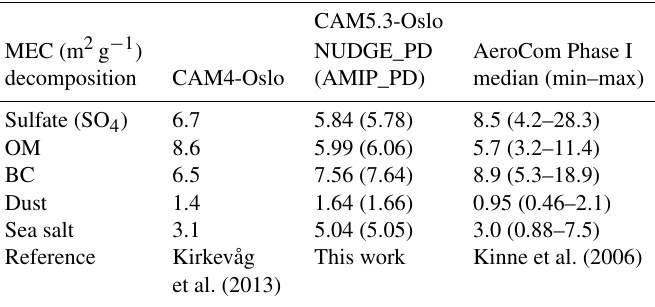
Table 9. Globally and annually averaged PD mass extinction coefficients at 550nm for each of the main aerosol components in CAM5.3- Oslo compared to CAM4-Oslo and to AeroCom Phase I models. For a component X we calculate MEC X = AOD X /B X , where B X is the burden of the component.